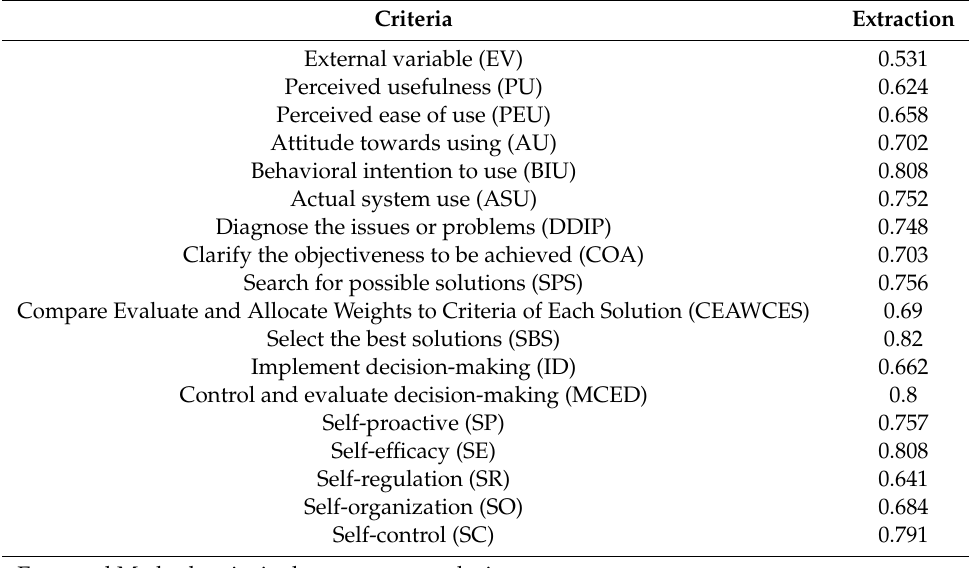
Table 4. The commonality of assessed criteria of FA approach.